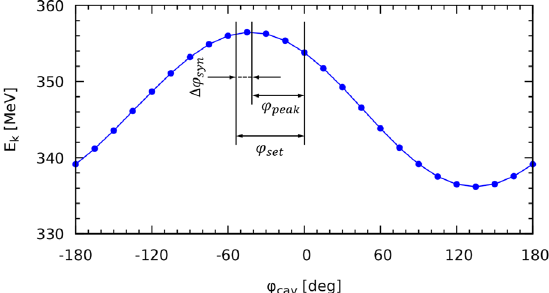
FIG. 9. Example of an SRF cavity phase calibration. The beam energy measured downstream of the cavity is plotted versus the phase setting of the input rf